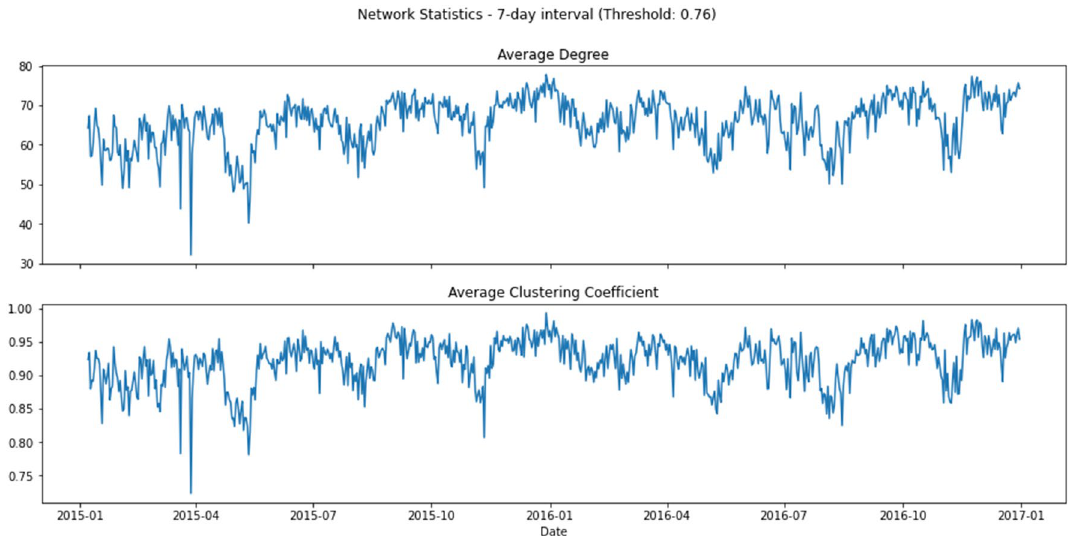
Figure 3. Network statistics, 1 January 2015 to 31 December 2016.